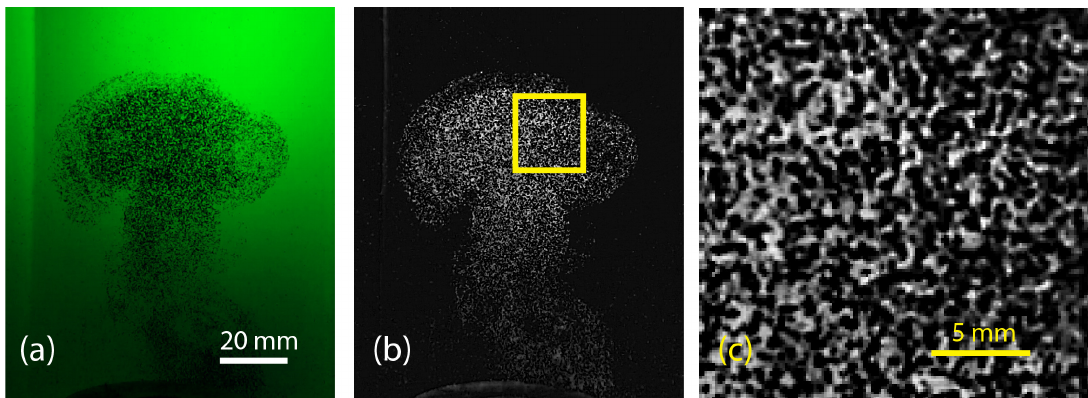
Figure 3. ( a ) Single frame of a Vortex ring from a High-speed video. ( b ) Post-processed image. ( c ) Magnification of a sampled area inside the yellow region in ( b